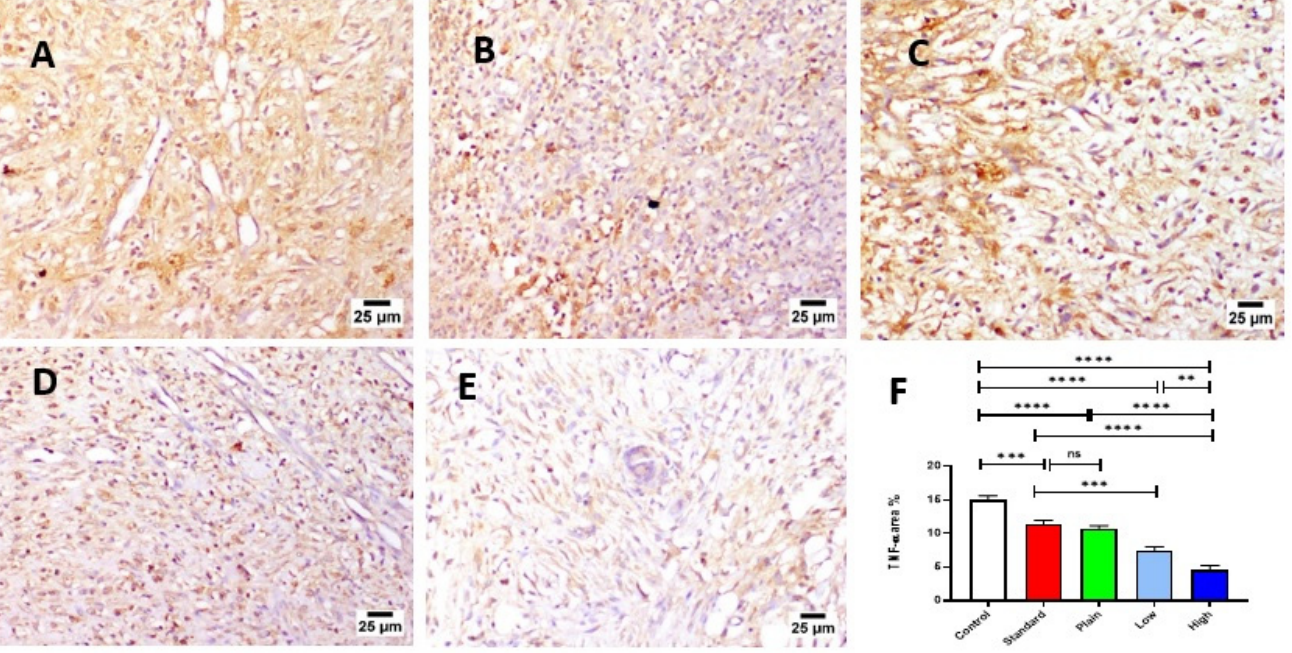
Figure 11. Tumor necrosis factor- α expression on the healed tissue. Microscopic images of skin, immunostaining of TNF- α . ( A ) Control group, ( B ) standard gentamicin (0.1% garamycin cream), ( C ) plain, ( D ) low, and ( E ) high ( F ) immune expression of TNF- α (area%). Data represented as mean ± SE of at least 5 wounds. **** for p < 0.0001, *** for p < 0.001, ** for p < 0.01, ns for non ‐ significant.